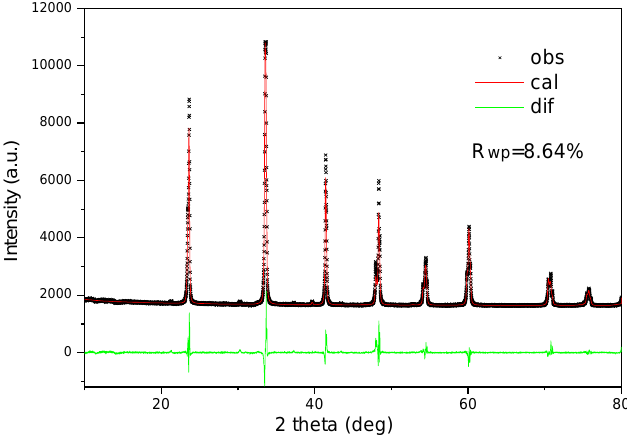
Figure 2. X-ray di ff raction (XRD) patterns of the as-grown CeAlO 3 Figure 2. X-ray diffraction (XRD) patterns of the as-grown CeAlO 3 crystal.